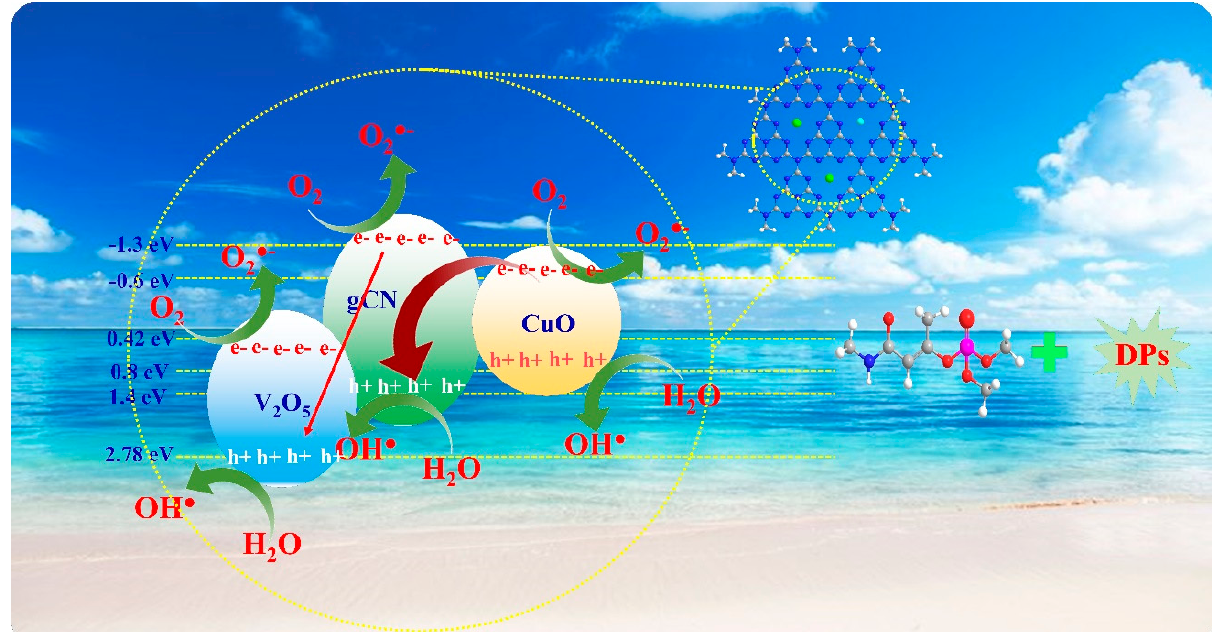
Figure 11. Possible photocatalytic reactions for MCP degradation.